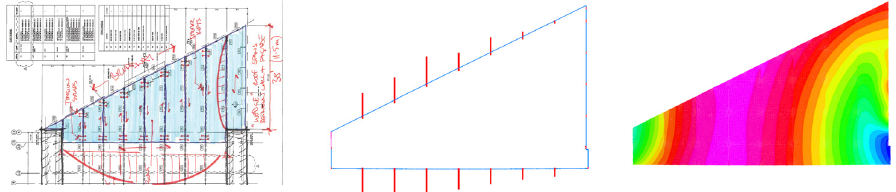
Figure 15: From left to right: structural scheme of horizontal beam in the roof plane; tension in fittings on top and bottom of the “beam”; deflections of the “beam”. Forces in the fittings are isolated and applied to more detailed models (below). The fittings in the wedge transfer combinations of tension, compression and shear.